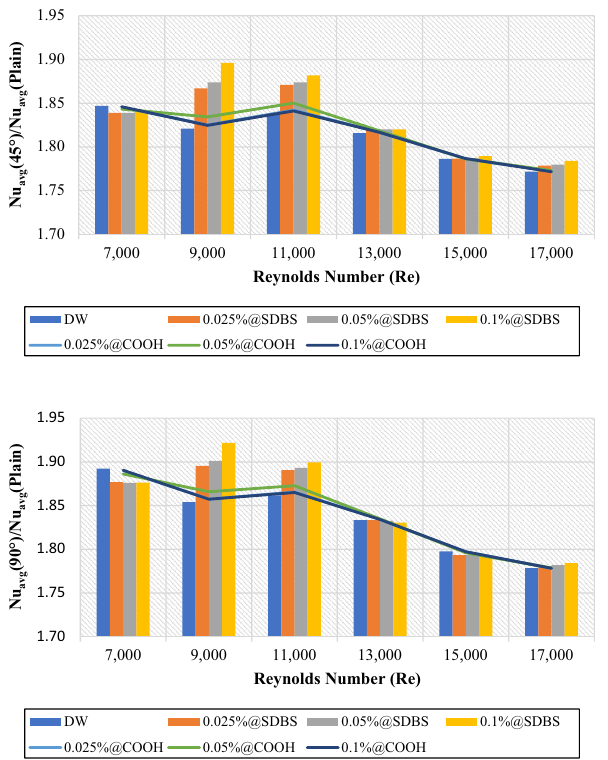
Figure 12. Average Nusselt number of (45° and 90° helix angles) relative to plain pipe versus Reynolds numbers for different